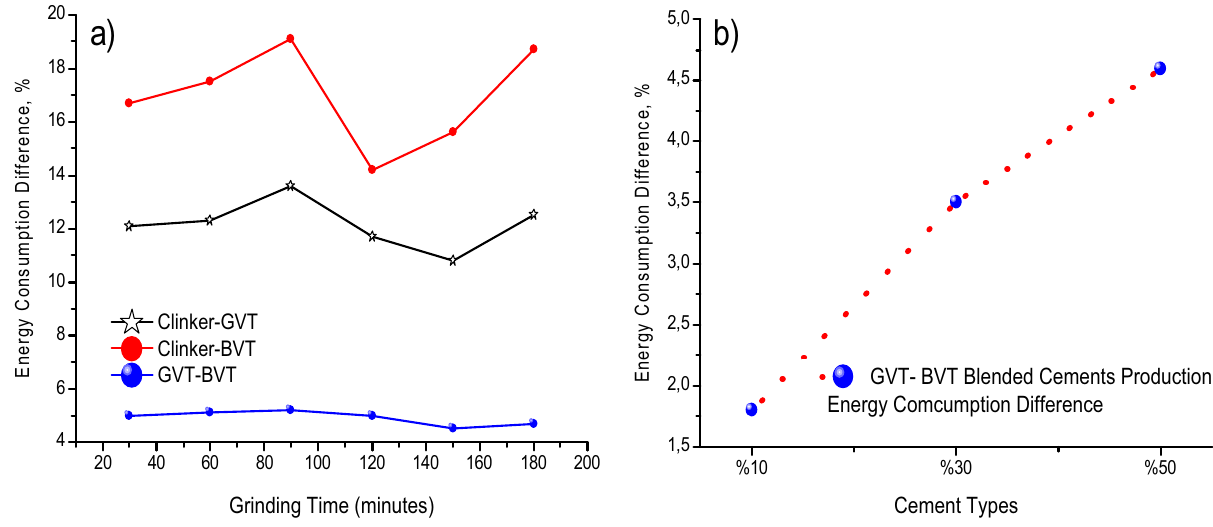
Figure 2: Energy consumption di ff erences of raw materials ( a ) and blended cement samples ( b )